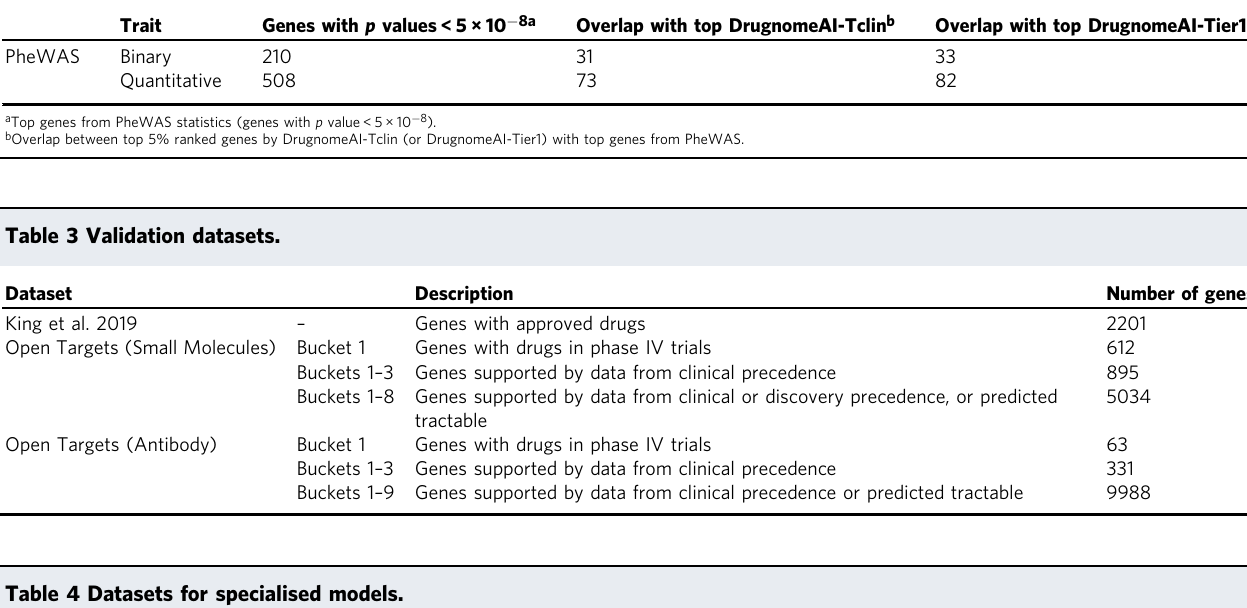
Table 2 Signi fi cant PheWAS hits and overlap with top DrugnomeAI results.